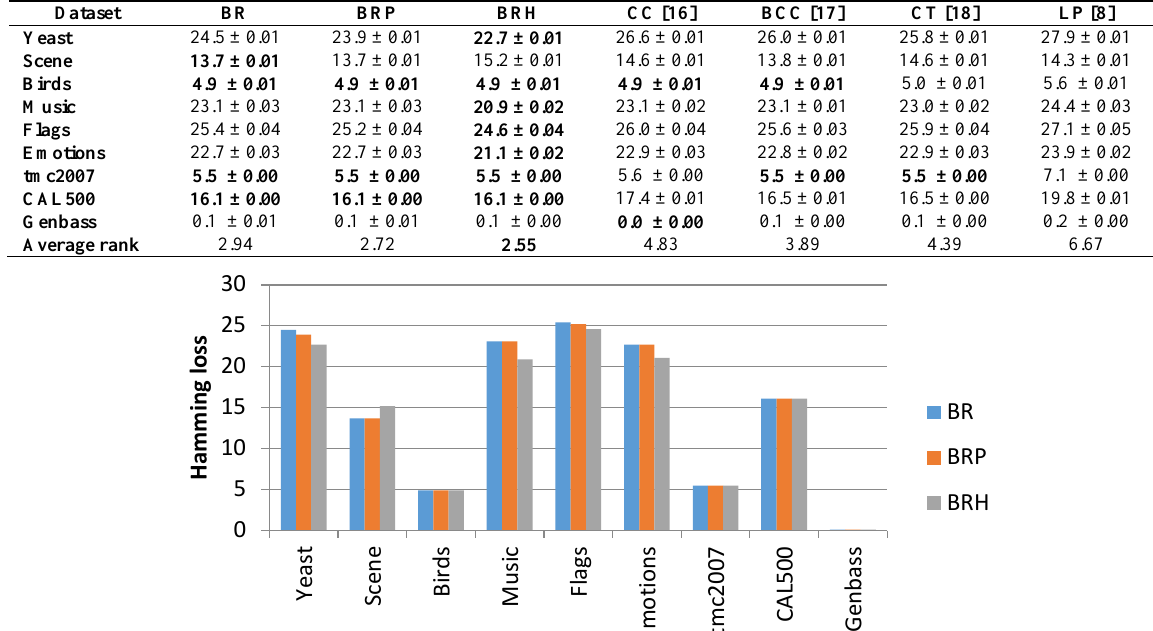
Table 7. Average and standard deviation of Hamming loss of rival algorithms. Best results are shown boldface. Dataset BR BRP BRH CC [16]